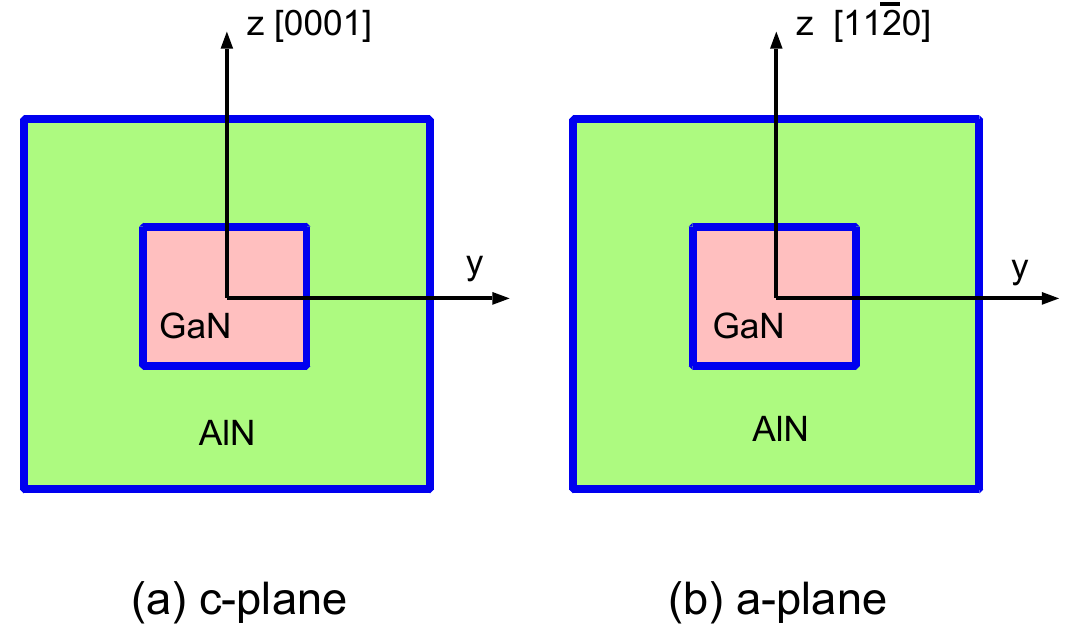
Figure 1. Schematic geometry for ( a ) c-plane and ( b ) a-plane QD